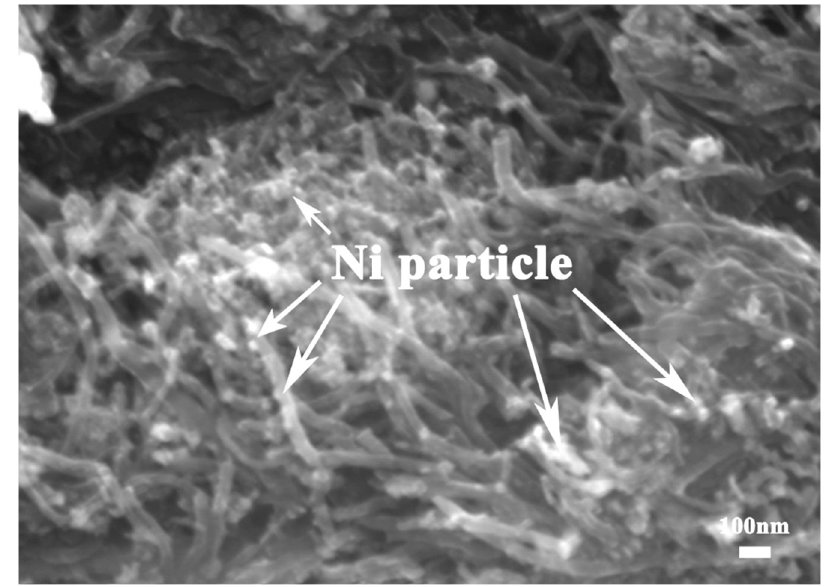
Figure 2. SEM morphology of nickel-plated CNTs.